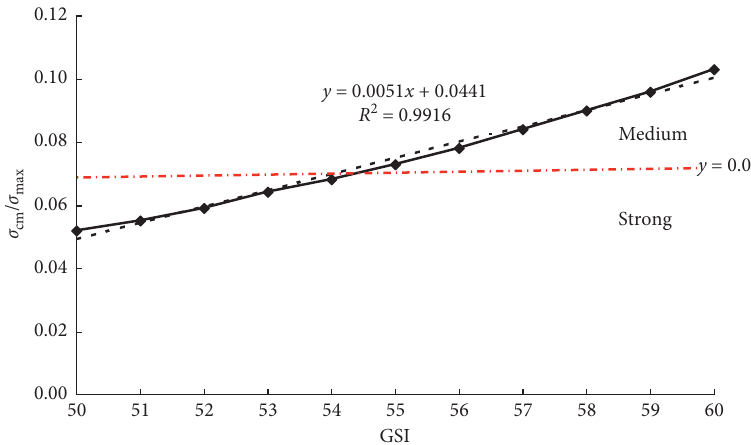
Figure 10: The relationship between GSI and the ratio of σ